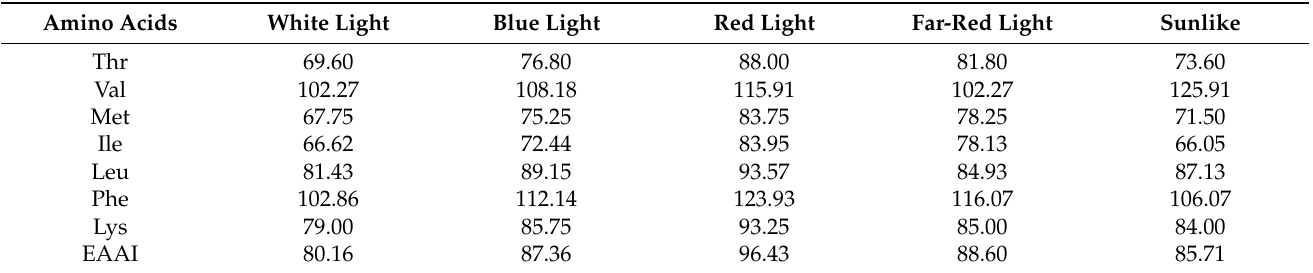
Table 7. Evaluation of the composition of essential amino acids in the proteins of P. eryngii fruiting bodies with different light quality treatments.